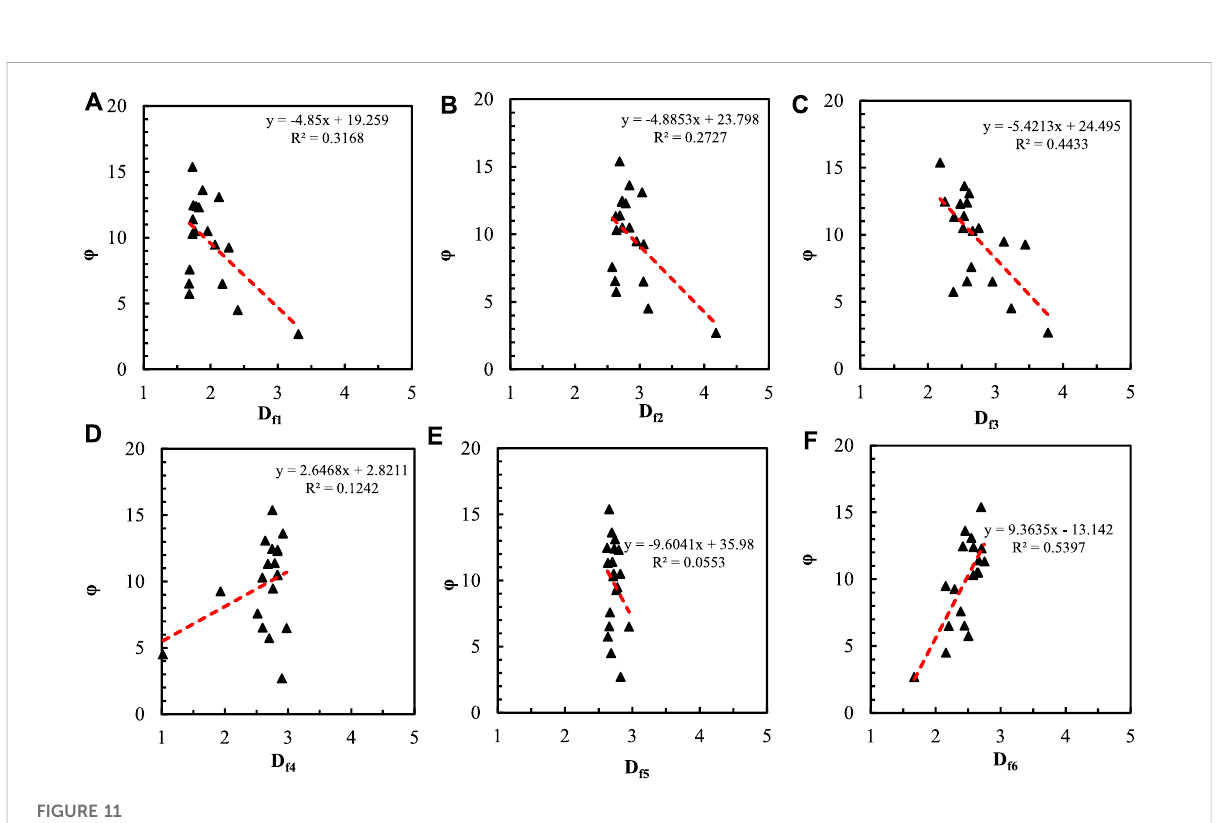
FIGURE 11 Relationship between porosity and fractal dimension calculated by six